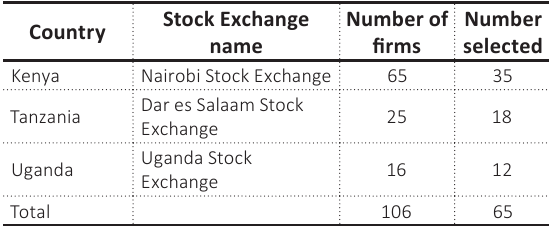
Table 1. Population and sample